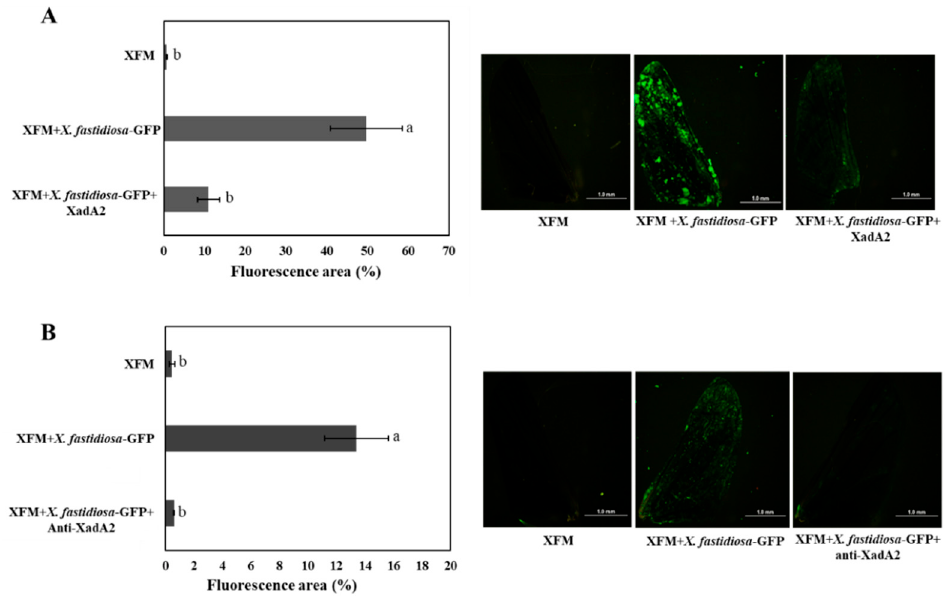
Figure 2. Use of Xylella fastidiosa XadA2 protein and specific antibody anti-XadA2 to block biofilm formation on Macugonalia leucomelas hindwings. ( A ) XadA2 as a competitor for insect binding sites on wings. ( B ) Use of specific antibody for the inactivation of X. fastidiosa XadA2. The graphics show the mean percentage (±SEM; n = 10) of fluorescent areas. Means followed by the same letters do not differ by Tukey’s test ( p < 0.05). The images were obtained by a stereoscopic microscope with a GFP filter (MVX10 Olympus Olympus Life Science) with 4× magnification and show the wing autofluorescence and fluorescence areas resulting from biofilm formation by X. fastidiosa -GFP on wings submitted to the different treatments.